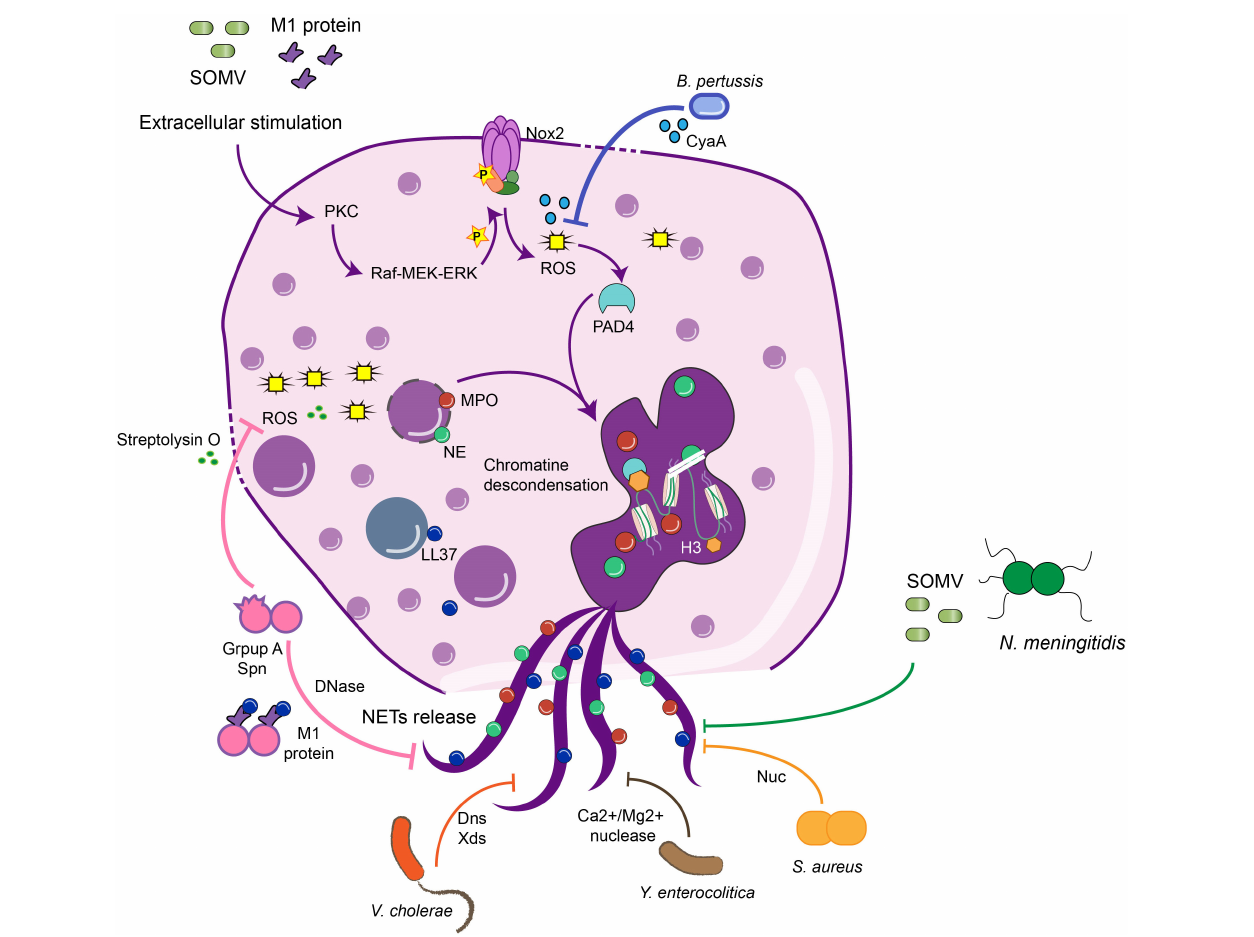
FIGURE 1 | Bacteria virulence factors that avoid NETs release against bacterial infection. Bacteria have evolved to develop different virulence factors to avoid the function of NETs, inhibiting different steps in the pathways required for the NETs release. B. Pertussis or GAS inhibit the action of ROS production by streptolysin O during the NETs pathway, which in the end inhibits the release of the structure. Nucleases are the main virulence factor shared among the bacteria which dismantle the NETs structure, and in this sense, the bacteria can disseminate and generate the disease. GAS, Group A Streptococcus ; MPO, myeloperoxidase; NE, neutrophil elastase; SOMV, small vesicles from the outer membrane into the environment; PAD4, peptidylarginine deiminase 4; Nuc, nuclease; LL37, cathelicidin.